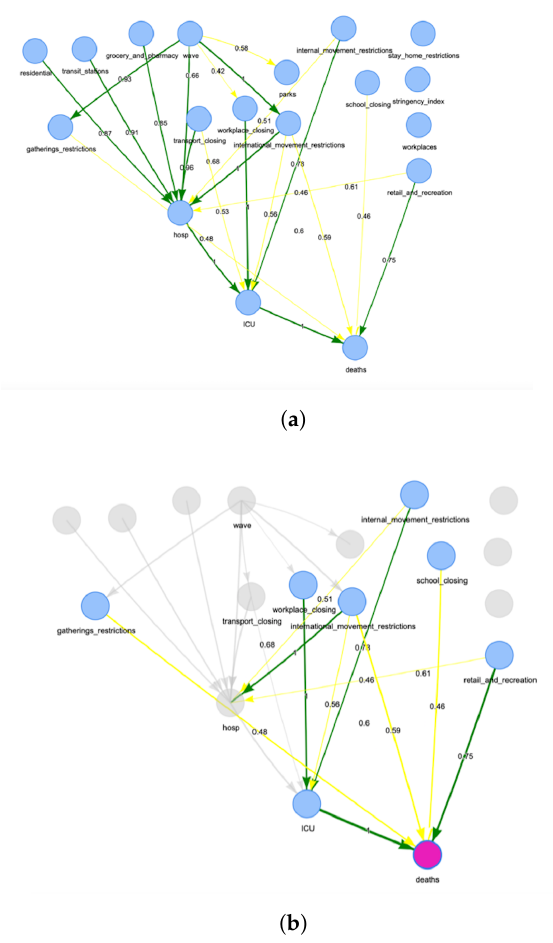
Figure 15. Network for Israel obtained using the bootstrap. ( a ) overall network; ( b ) connections to the node ‘ deaths ’ in the network. The figures are downloadable at https://tinyurl.com/rbexhtww (accessed on 26 February 2022).